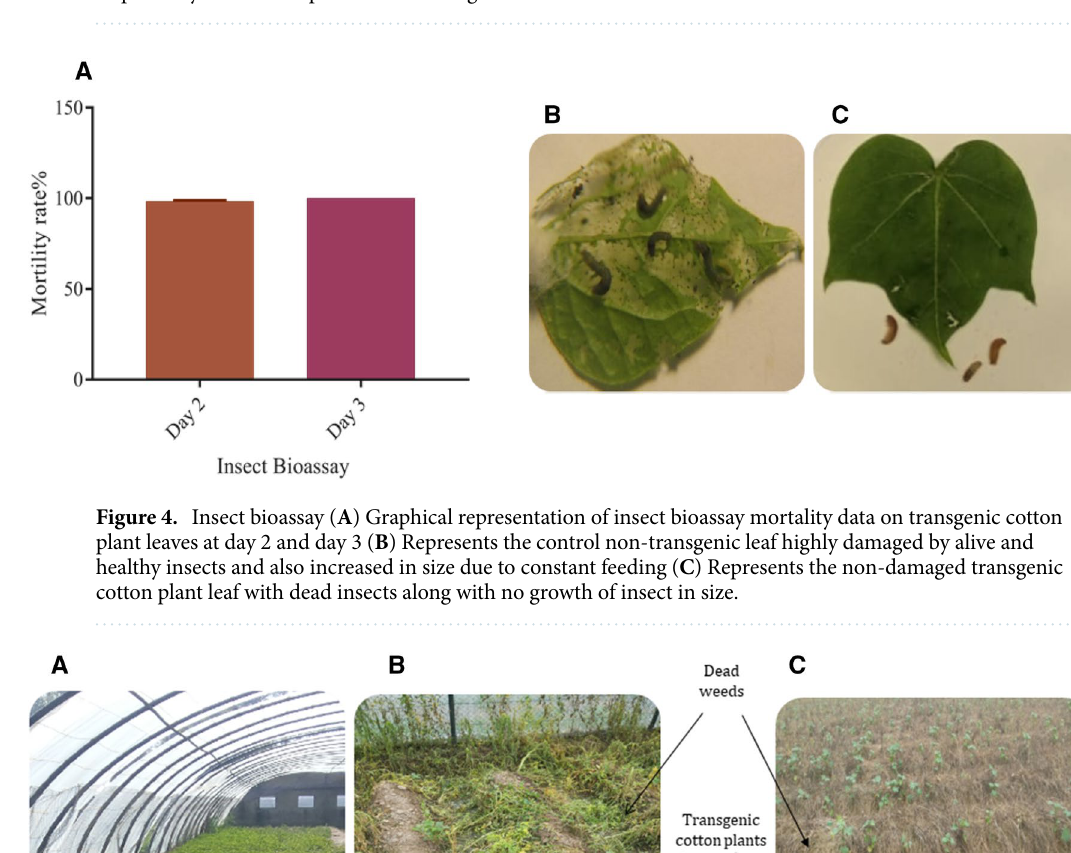
Figure 3. Graphs showing comparative expression of Cry and cp4EPSPS proteins of transgenic plants in Multan and Lahore fields. ( A ) Represents the expression of Cry1Ac in PCR confirmed transgenic plants at different time intervals respectively ( B ) Represents Cry2a in PCR confirmed transgenic plants at different time intervals respectively ( C ) Represents cp4EPSPS PCR in confirmed transgenic plants at different time intervals respectively. Each bar represents the average value of 9 selected lines from both Multan and Lahore field.